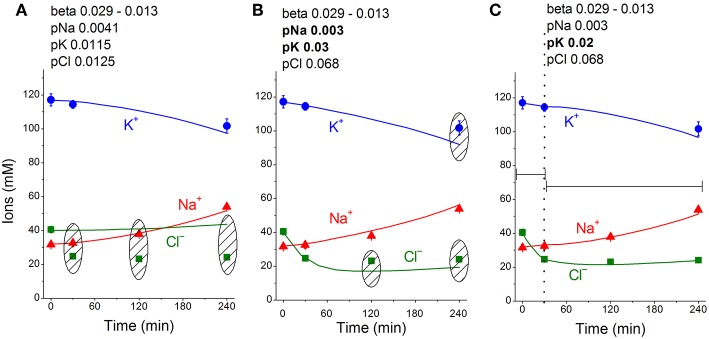
Time course of [K+], [Na+] and [Cl−] in real U937 cells treated with 1 μM STS (symbols) and calculated (lines) for different parameter datasets. Symbols—experimental data, means ± SEM from three independent experiments with duplicate determinations. Small SEM values are masked by symbols. Lines—calculated data obtained for the parameters indicated on the graphs. The initial parameters were na0 140, k0 5.8, cl0 116, B0 48.2, kv 1, na 32, k 117, cl 40, beta 0.029, gamma 1.5, pna 0.0041, pk 0.0115, pcl 0.0125, inc 0.000003, ikc = inkcc = 0, and kb 0.000068. The changed parameters are shown in the layers head. (A) Linear decrease in beta only. (B) Decrease in beta and changes in pna, pk, and pcl. (C) Additional decrease in pk. Shaded regions show significant disagreement of experimental and predicted values. The calculated data were obtained by using code BEZ01B.